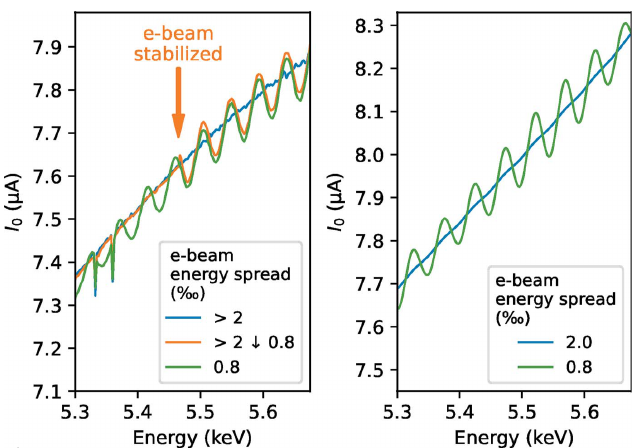
Figure 7 Left: experimental wiggler spectra at various e-beam energy spreads. A large energy spread is not typical and was due to a transient e-beam instability. The stabilization regain was instantaneous and happened during an energy scan (the orange curve). Right: calculated spectra under similar conditions.